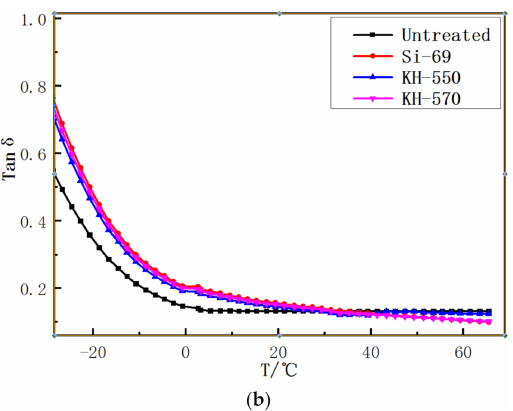
Figure 7. DMA curves of vulcanizates with di ff erent silane coupling agents ( a ) Dynamic mechanical analysis (DMA) and ( b ) DMA local amplification.